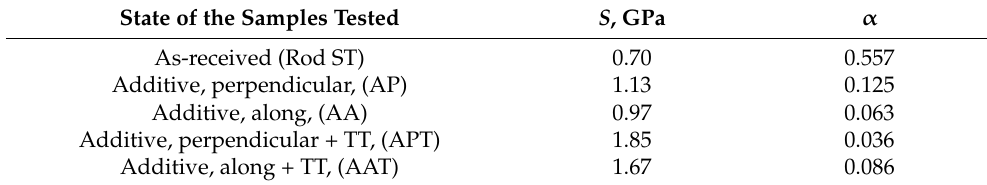
Table 4. The coefficient S and the power exponent α of the approximating function in Equation (6). State of the Samples Tested